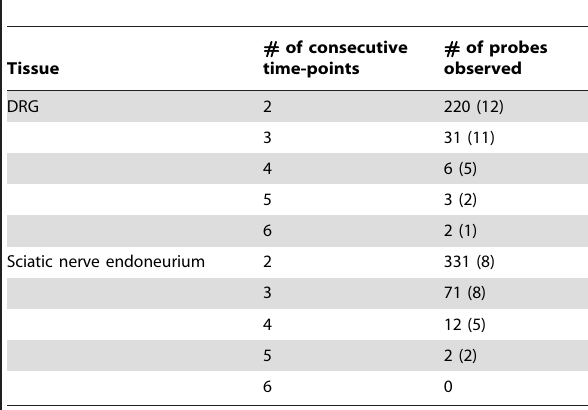
Table 1. Number of probes differentially expressed between Ins2 Akita/ + and Ins2 + / +